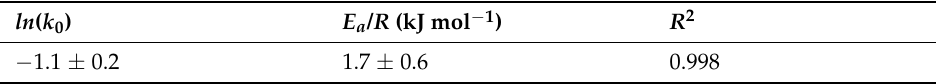
Table 4. Kinetic parameters obtained from the Arrhenius plot.